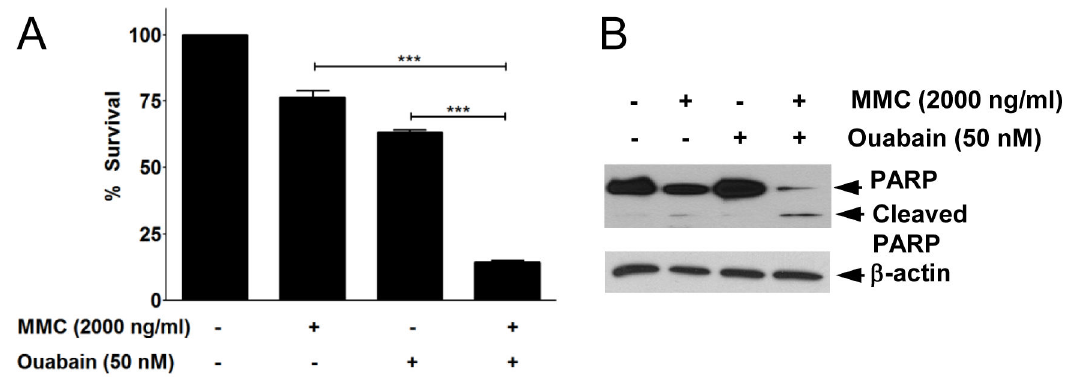
Figure 5. Ouabain enhances cytotoxicity of MMC against U2OS cells. (A) U2OS cells were pretreated with the 50 nM ouabain for 1 h and then treated with 2000 ng/ml MMC. After incubation for 48 h, cell viability was measured with the MTT assay. Values represent the means ± SEM from three independent experiments (Student’s t -test, ***, P < 0.001). (B) Protein extracts from U2OS cells treated as described in (A) were analyzed by Western blotting using antibodies against PARP-1. Proform of PARP (116 kDa) and cleaved PARP (85 kDa) are indicated.